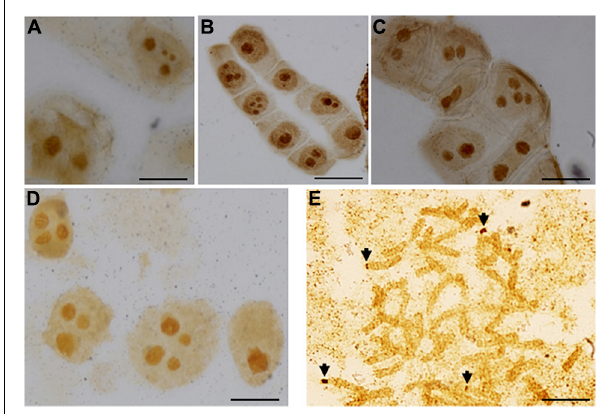
FIGURE 1 | Silver stained nucleoli of (A) A. cylindrica , (B) A. sylvestris , (C) A. multifida and (D) A. baldensis . (E) Silver stained chromosomes of A. baldensis . NORs as well as NOR-bearing chromosomes are marked with arrow. Bar = 10 µ m.